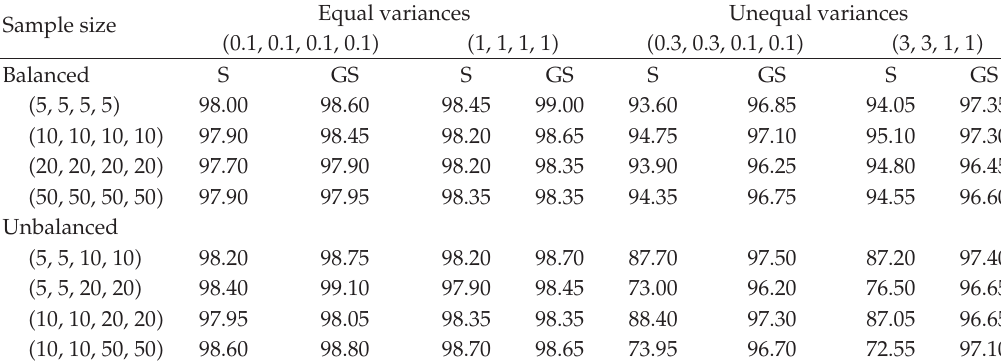
Table 1: Coverage rates of 95% Sche ff ´e’s intervals (cid:3) S (cid:4) and generalized Sche ff ´e (cid:3) GS (cid:4) intervals: two sets of inferences are considered, the population means and pairwise mean di ff